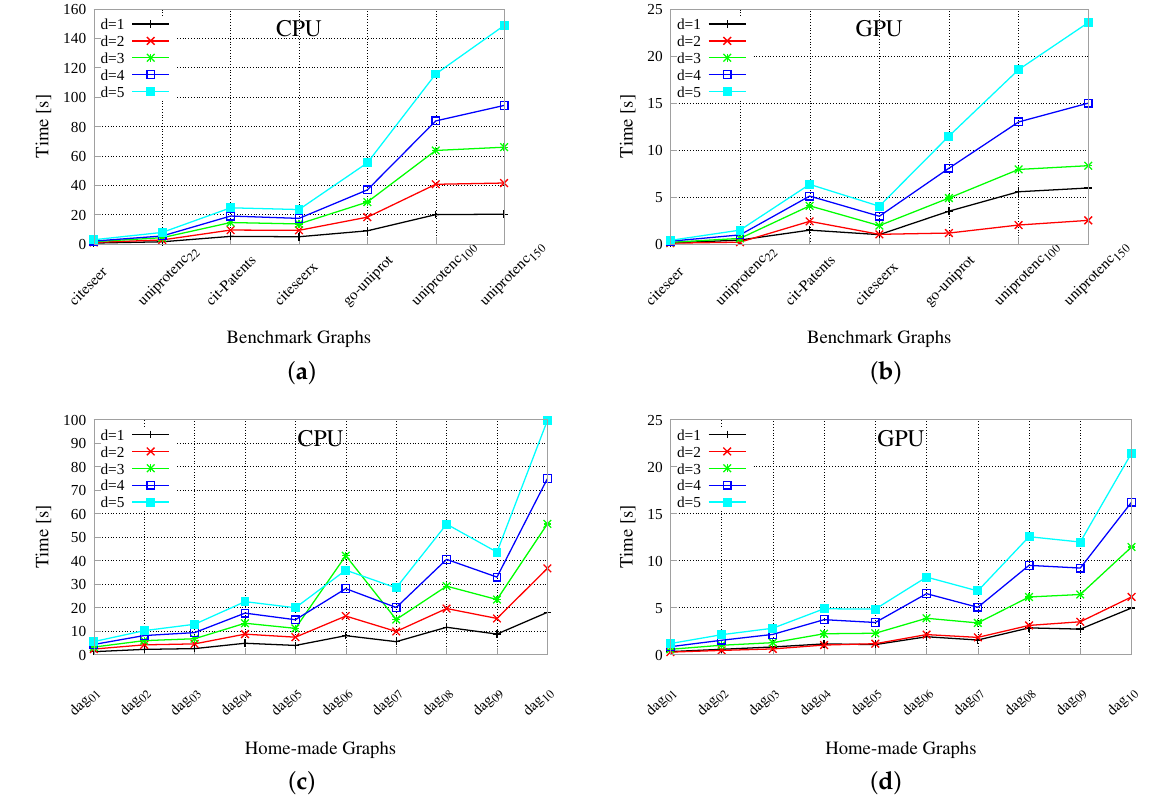
Figure 4. Labeling results on benchmark and home-made graphs. The labeling times are reported in seconds, for different labeling size (from d = 1 to d = 5), Plots ( a , c ) reports the time for the original GRAIL implementation. Plots ( b , d ) the ones for the GPU-based version. A value equal to 3600 s (1 h) corresponds to a time